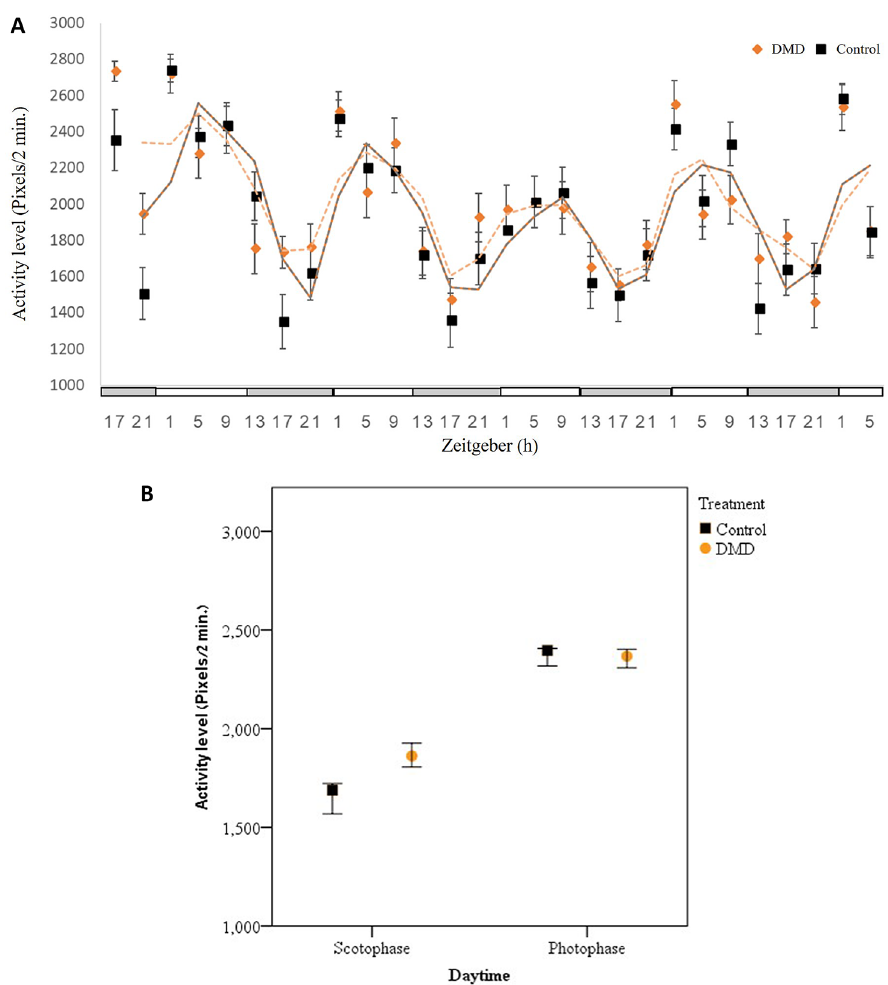
Figure 3. Activity level in response to DMD (mean ± SE). Activity level recording (pixels/2 min.) of control beetles (black trendline) and DMD exposed beetles (red dotted trendline) over five consecutive days (bars below X-axis indicate on lights on (white bar) and lights off (grey bar) phase. In both cases, there is significant rhythmicity with a common peak of activity (Zt 1 to Zt 5, A ). White and black bars indicate light phase and night, respectively. The synthetic aggregation pheromone increased activity ( B ). This increase is attributed to the dark phase